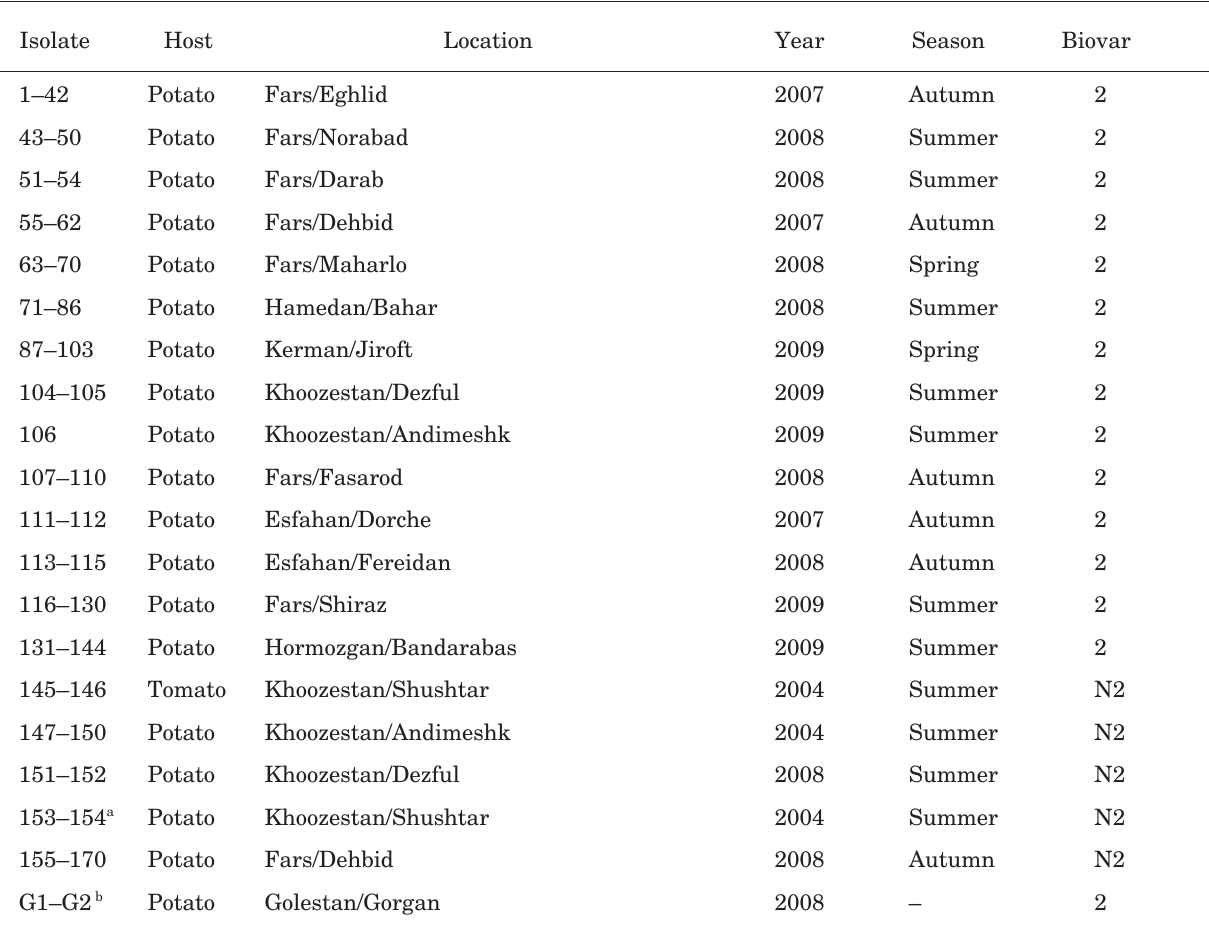
Table 1. Characteristics of Ralstonia solanacearum isolates used in this study.